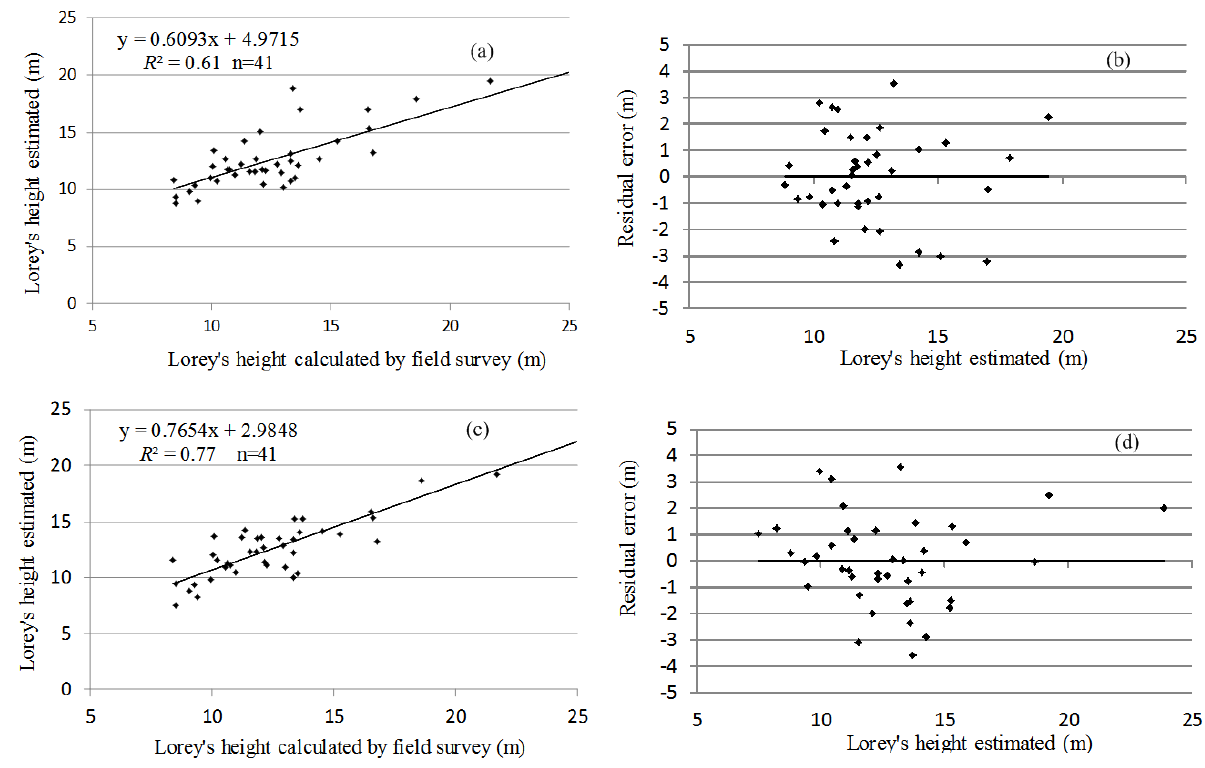
Figure 13. Correlation and residual error of the estimated Lorey’s height before and after terrain correction. ( a ) Correlation of the estimated Lorey’s height before terrain correction; ( b ) Residual error of the estimated Lorey’s height before terrain correction; ( c ) Correlation of the estimated Lorey’s height after terrain correction; ( d ) Residual error of the estimated Lorey’s height after terrain